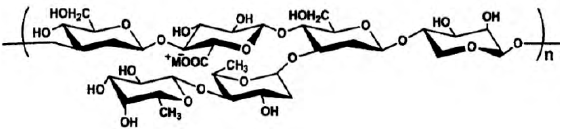
Figure 11. Chemical structure of diutan gum.